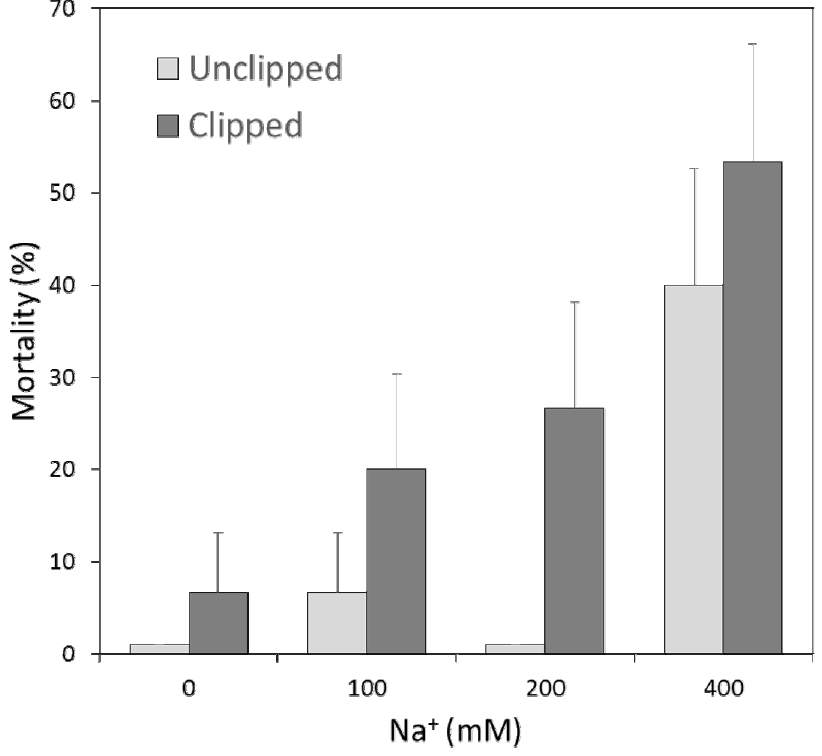
different Na concentrations and separated by defoliation treatment. Mortality is the percentage plants that died in a given group, across all species. Bars represent means ± SD of the Bernoulli distribution. Means of 0 (no error bars) have been “bumped” up to indicate the presence of data. Na and defoliation both have significant main effects in a Cox proportional hazards regression; however, the interaction effect was not